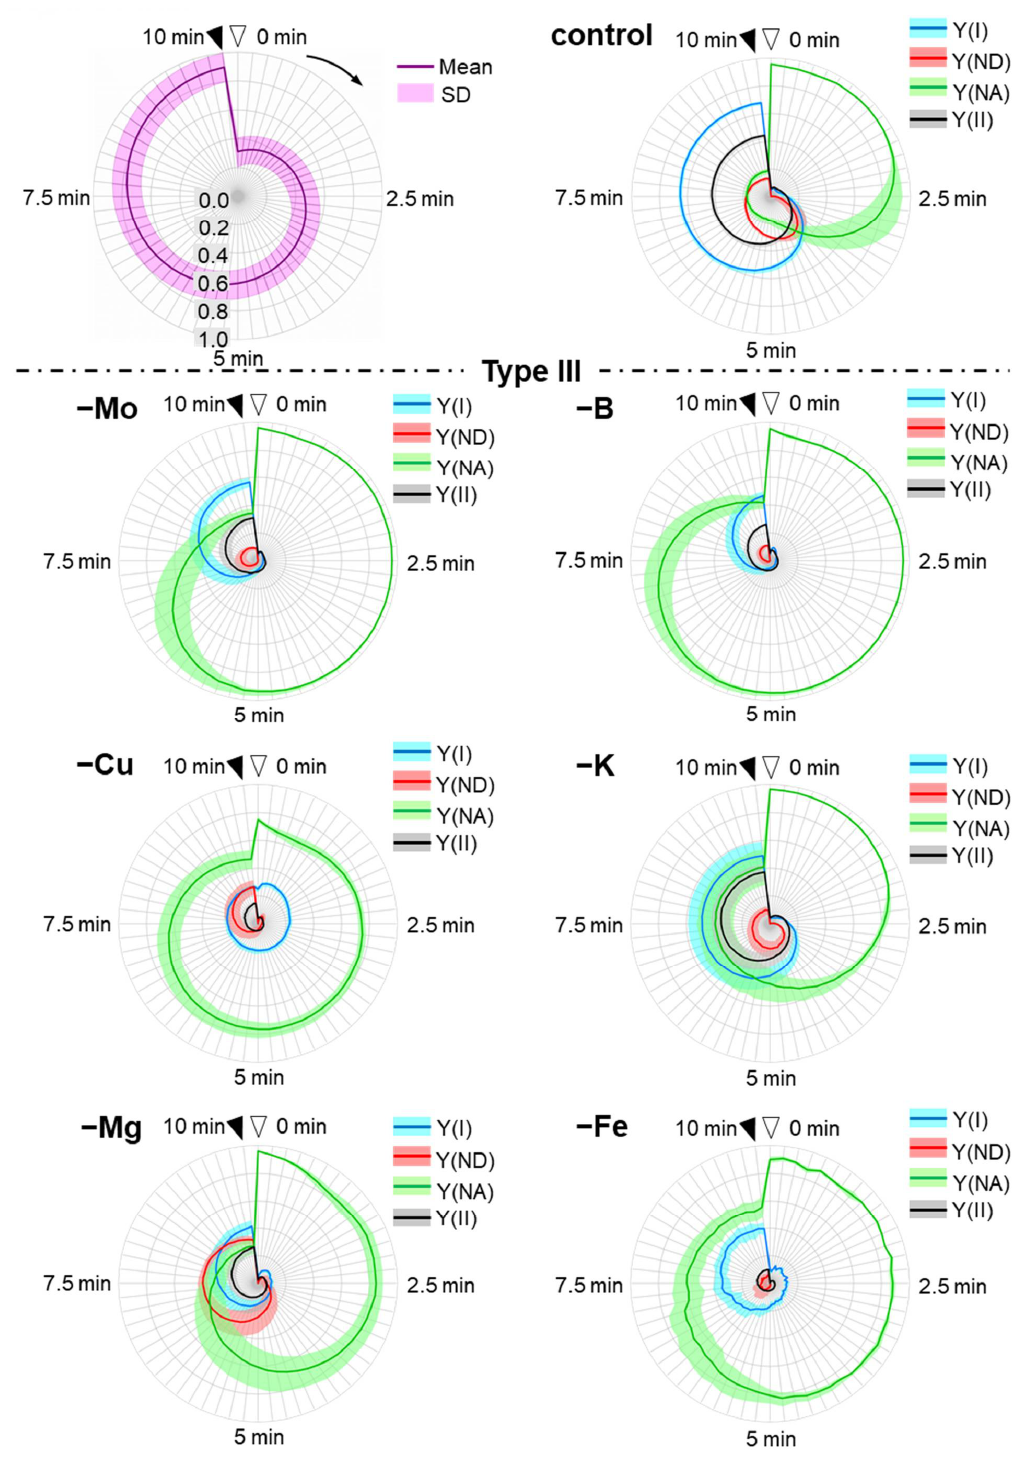
Figure 3. Effects of the nutrient-deficiency treatments on the induction of the photosynthesis parameters for PSI and PSII in the intact leaves of sunflower plants ( Helianthus annuus ). Data are taken from Figure 1. These parameters [Y(I), blue; Y(ND), red; Y(NA), green; Y(II), black] during the induction of photosynthesis were plotted against the AL illumination time in the radar-chart plots (Original plots). Nutrient-deficiency treatments are follows: Type-I: nitrogen deficiency (–N); phosphate deficiency (–P). Type-II: calcium deficiency (–Ca); zinc deficiency (–Zn); sulfur deficiency (–S); manganese deficiency. Type-III: molybdenum deficiency (–Mo); copper deficiency (–Cu); magnesium deficiency (–Mg); boron deficiency (–B); potassium deficiency (–K); iron deficiency (–Fe). Data are shown as mean values (line) + standard deviation (shadow) and were calculated from the data collected from our four